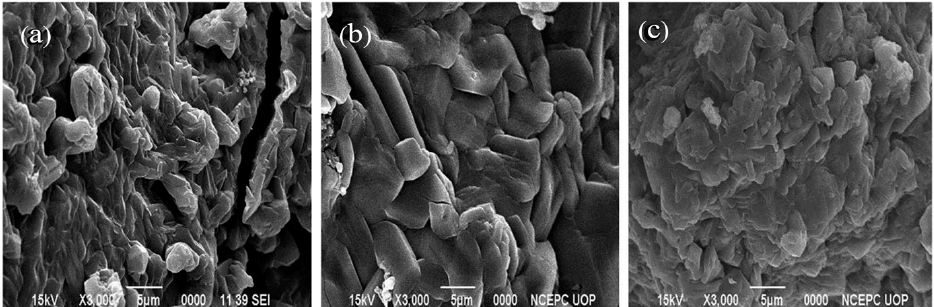
Figure 9. SEM micrograph of ( a ) anionic P(MAA), ( b ) neutral P(AAm), and ( c ) cationic P(APTMACI) hydrogels [155].